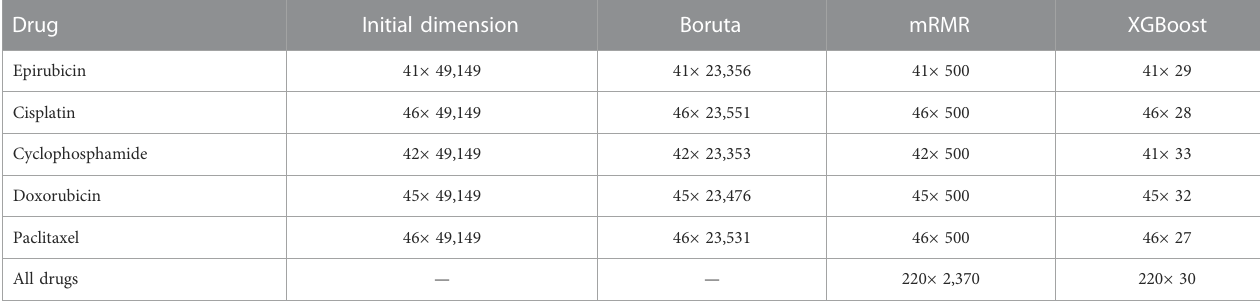
TABLE 1 Number of features selected by three-layer feature